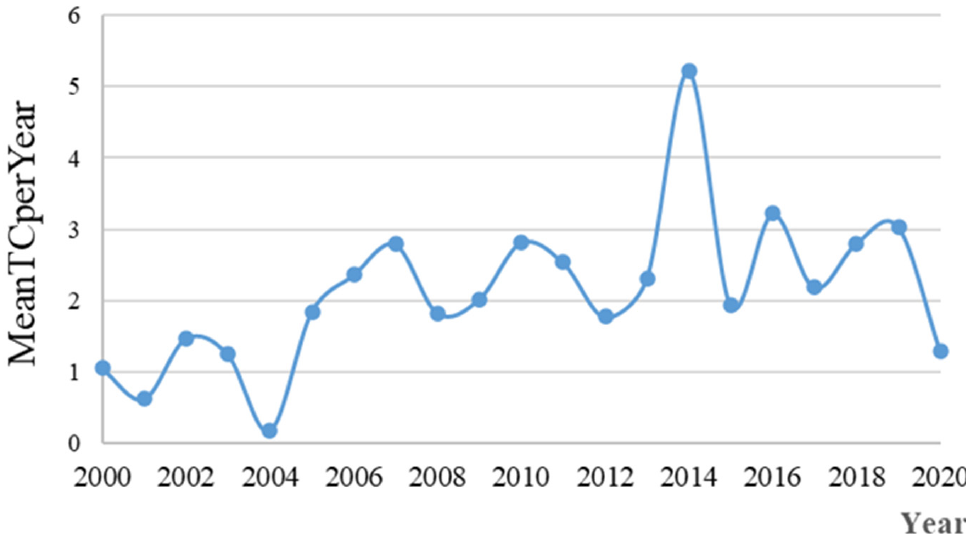
Figure 3. The number of annual cited papers.